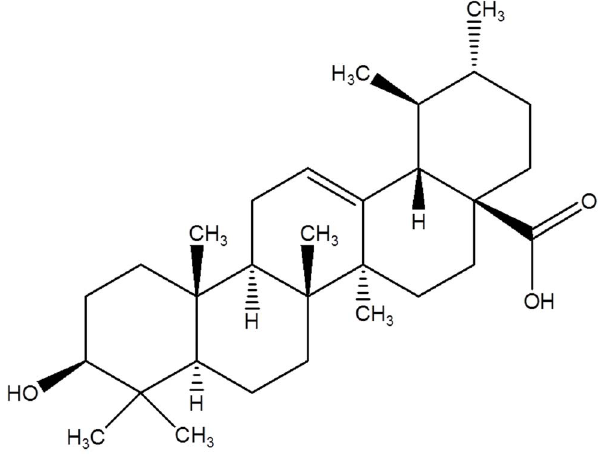
Figure 2. 2D structure of Ursolic Acid (UA).